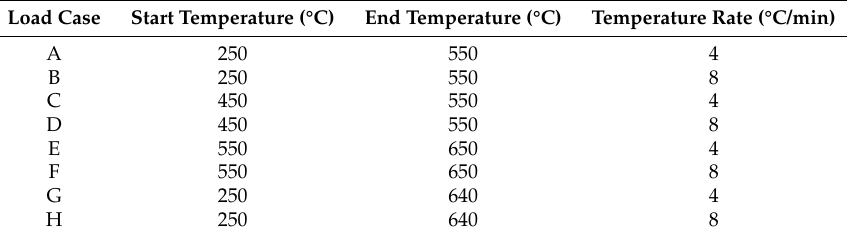
Figure 2. A summary of the temperature-dependent material properties used in the present work to represent a P91 chrome steel. Table 3. A summary of bulk steam temperature “ramp up” profiles.